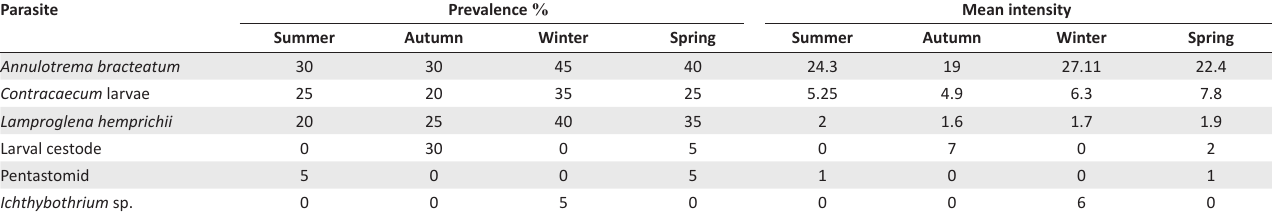
TABLE 2: Prevalence and mean intensity per season of metazoan parasites of Hydrocynus vittatus ( n = 20) per season. Parasite Prevalence % Mean